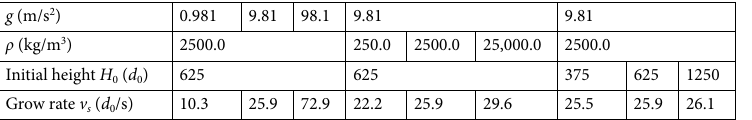
Table 2. Growth rate of the shell v s , varying with gravity, particle density and initial height. λ = 0.